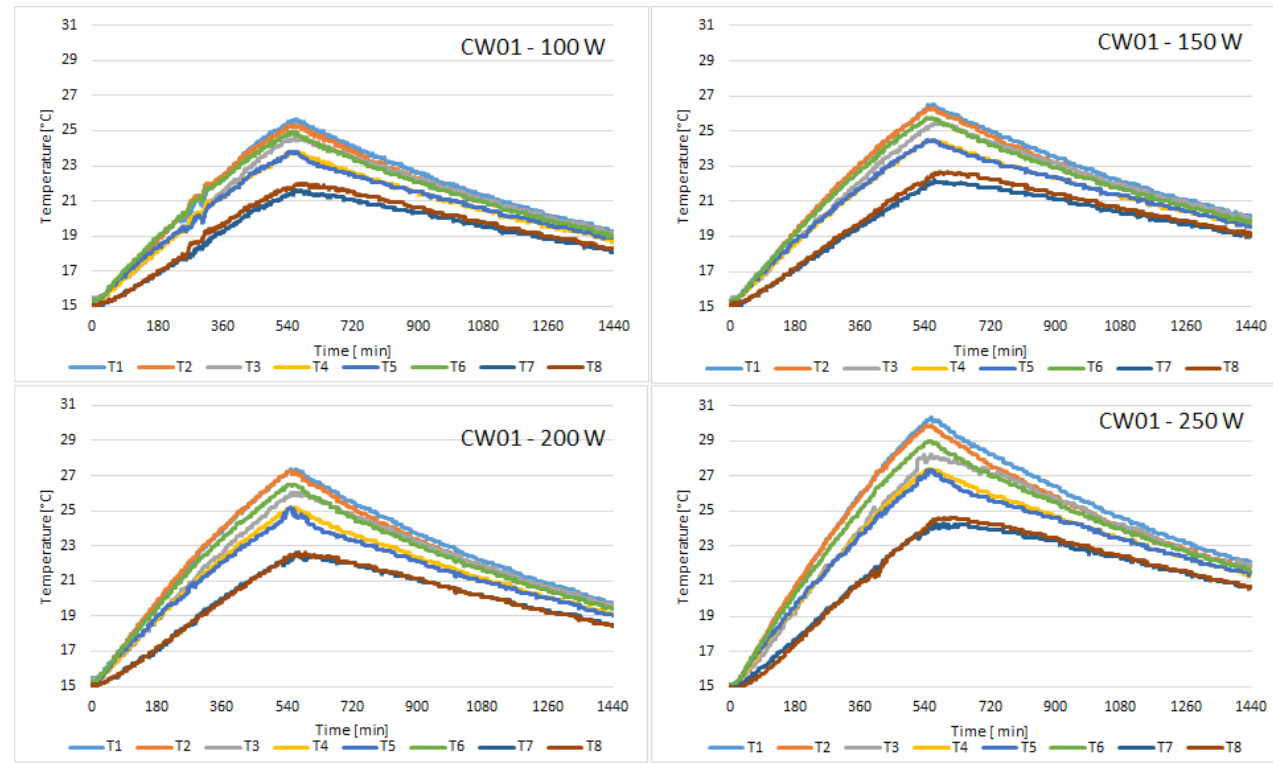
Figure 4. Temperature variation recorded by the sensors for concrete sample CW01.